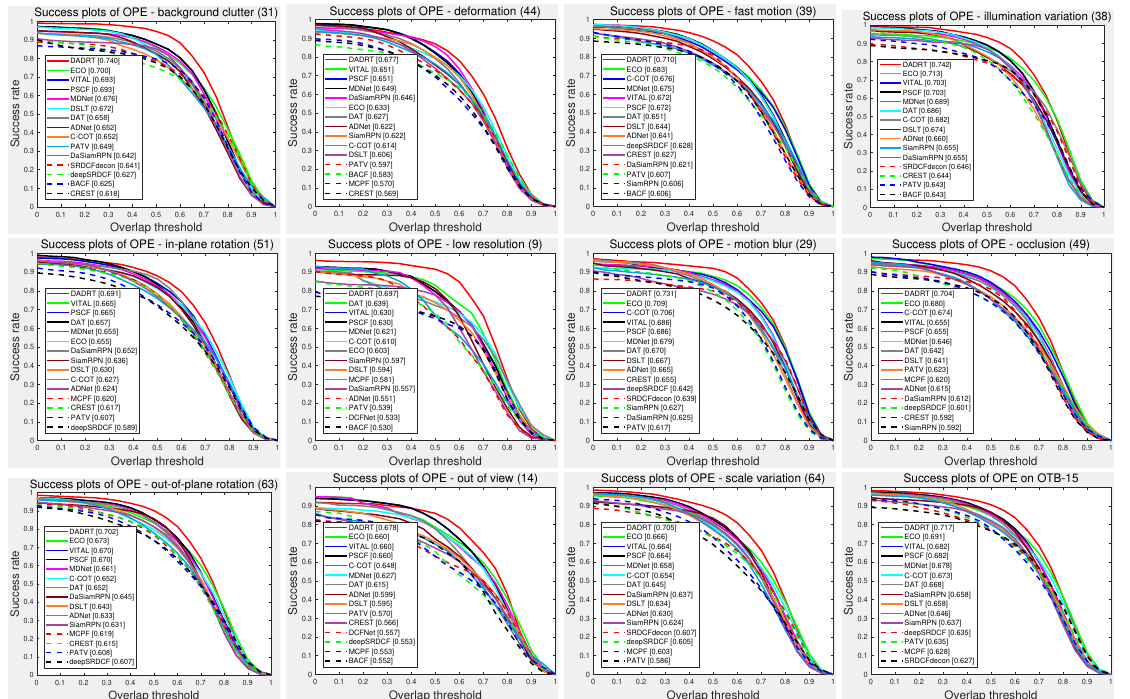
Figure 6. Overlap success plots under the eleven annotated video attributes. We only show the top 10 trackers for each challenging attribution. Our tracker ranked first in all attributes. Results are best viewed on high-resolution